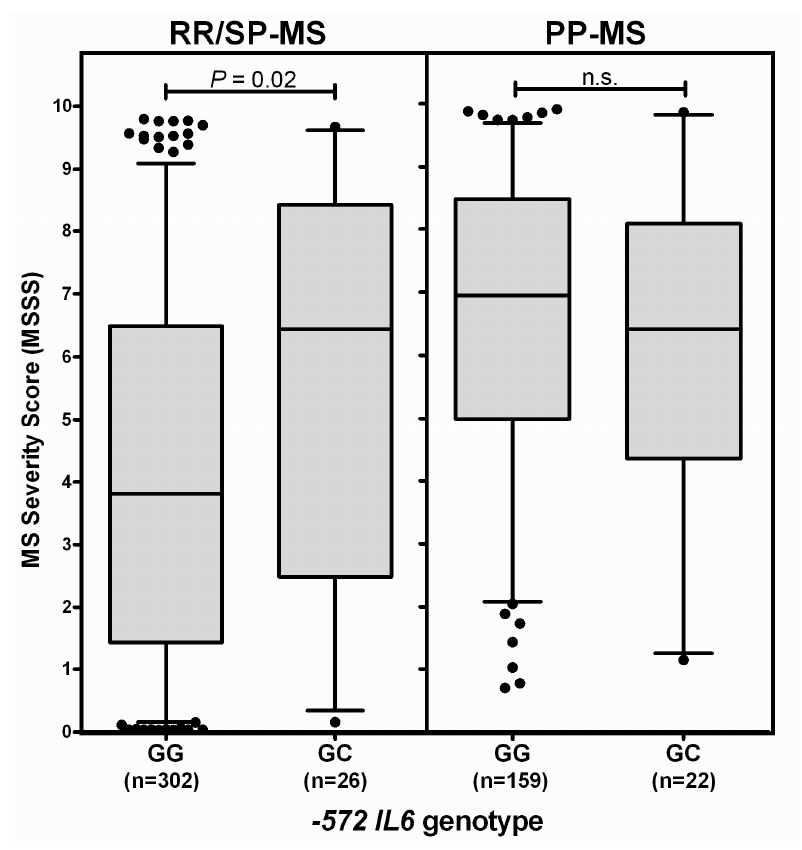
Figure 5. MS Severity Scores in patients who initially have a RR-MS course, compared to a PP-MS course, by − 572 IL6